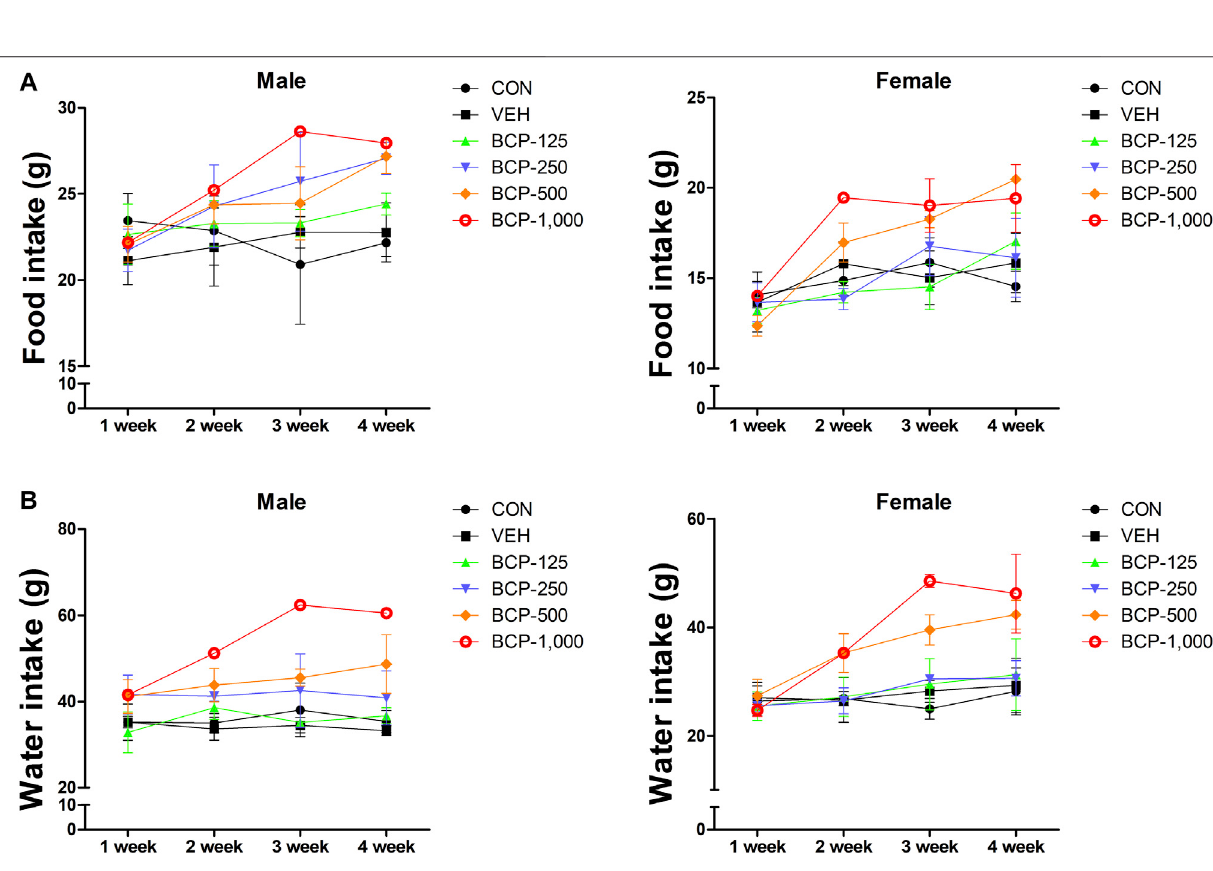
Frontiers in Pharmacology |